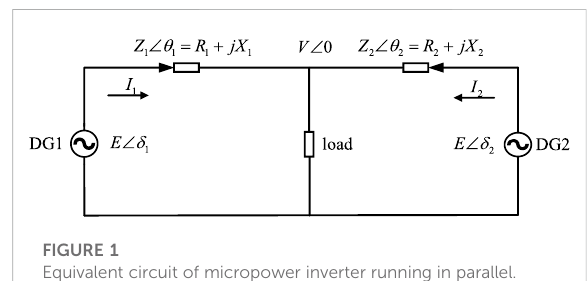
FIGURE 1 Equivalent circuit of micropower inverter running in